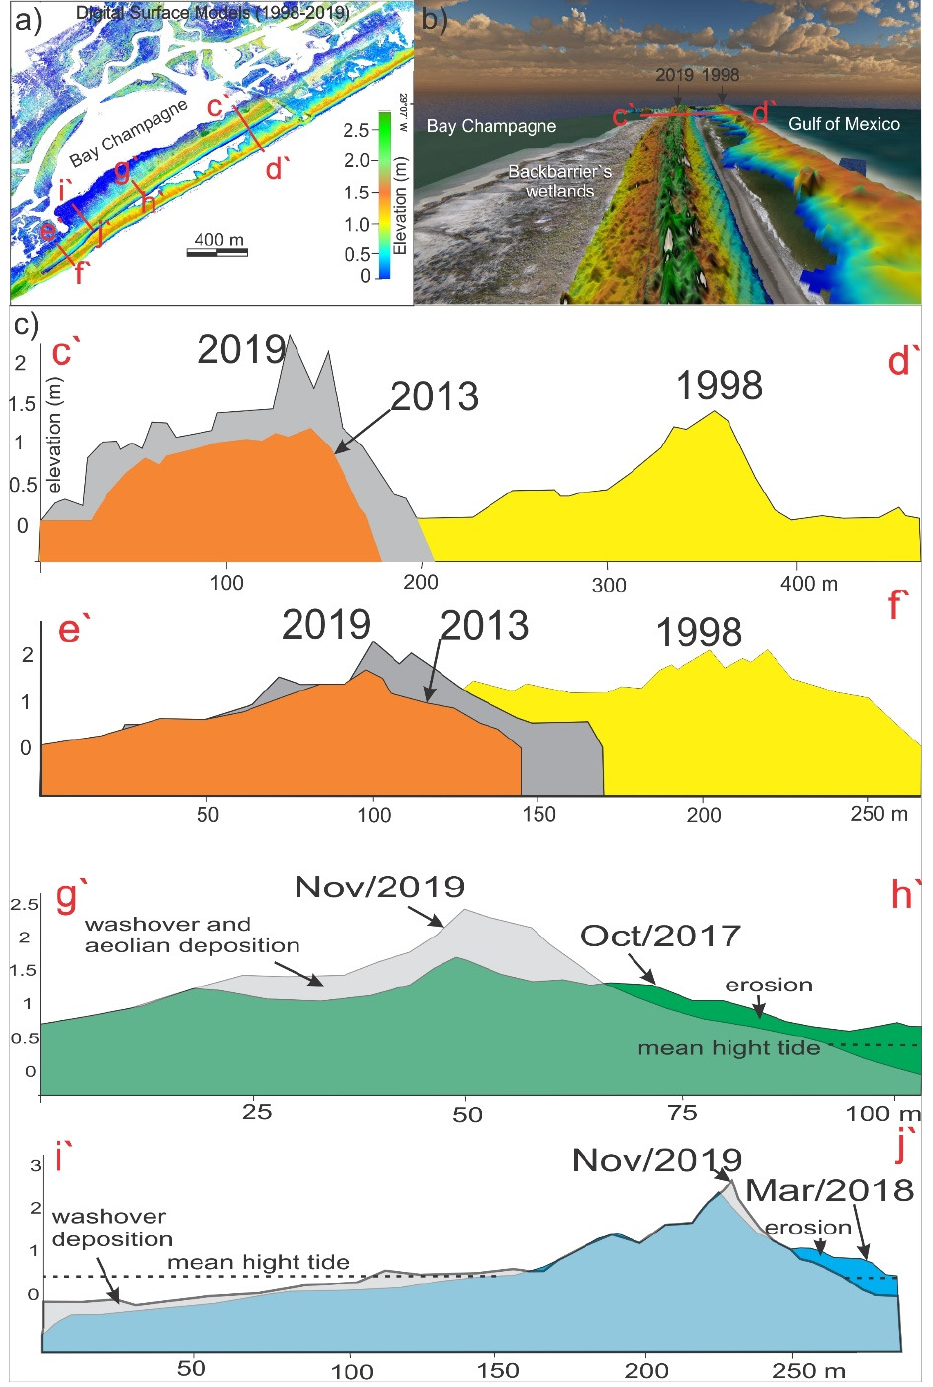
Figure 3. ( a ) Comparison between the digital surface models of 1998 and 2019, ( b ) perspective of the digital elevation models of the beach barrier between 1998 and 2019, and ( c ) planialtimetric cross-shore profiles, showing the dune crest positions based on Lidar and drone data in the time intervals: 1998—2019 (transects c`—d` and e`—f`), Oct/2017—Nov/2019 (transect g`—h`), and Mar/2018—Nov/2019 (transect i`—j`).